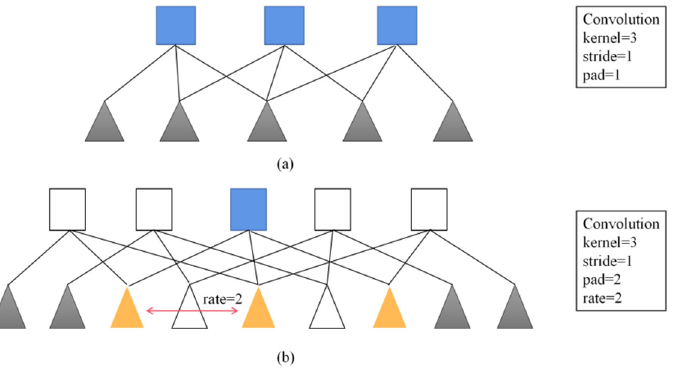
Figure 3. One-dimensional view of atrous convolution. ( a ) Convolution. ( b ) Atrous